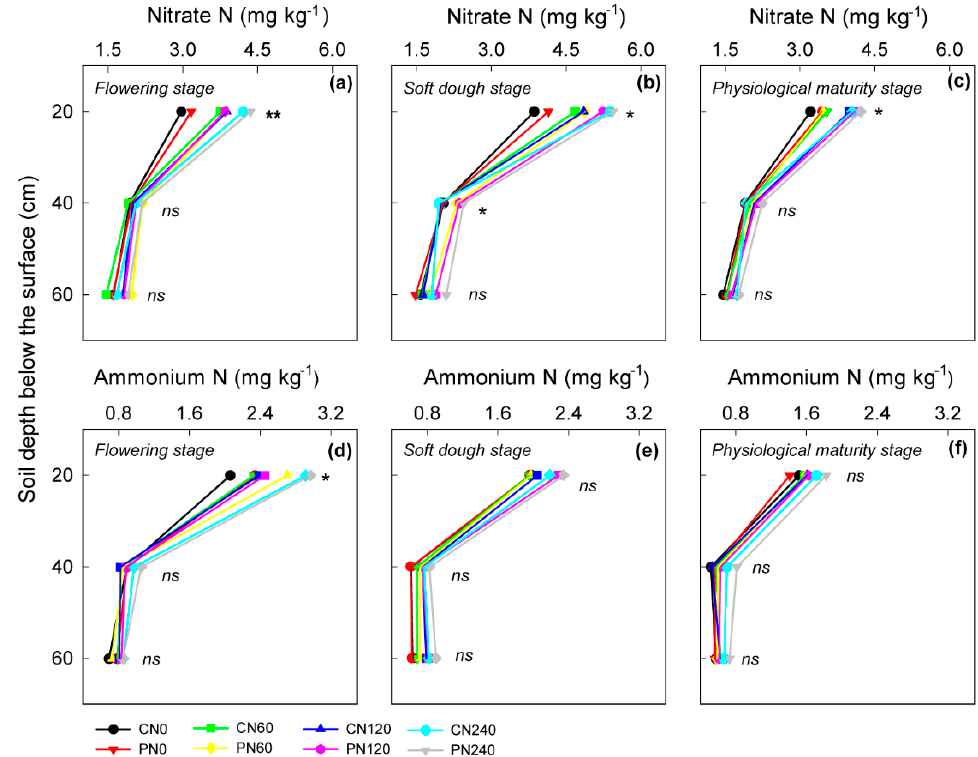
Figure 3. Effects of the control treatment (CK) and polyaspartic acid-coated urea (PN) on 0 − 60 cm topsoil nitrate N ( a − c ) and ammonium N ( d − f ) during the sorghum flowering ( a , d ), soft-dough ( b , e ), and physiological maturity ( c , f ) stages at 0 − 240 kg N ha − 1 nitrogen application rates in 2020 and 2021. * and ** represent a significant difference between CN and PN at the 0.05 and 0.01 levels, respectively, and ns represents no significant difference.